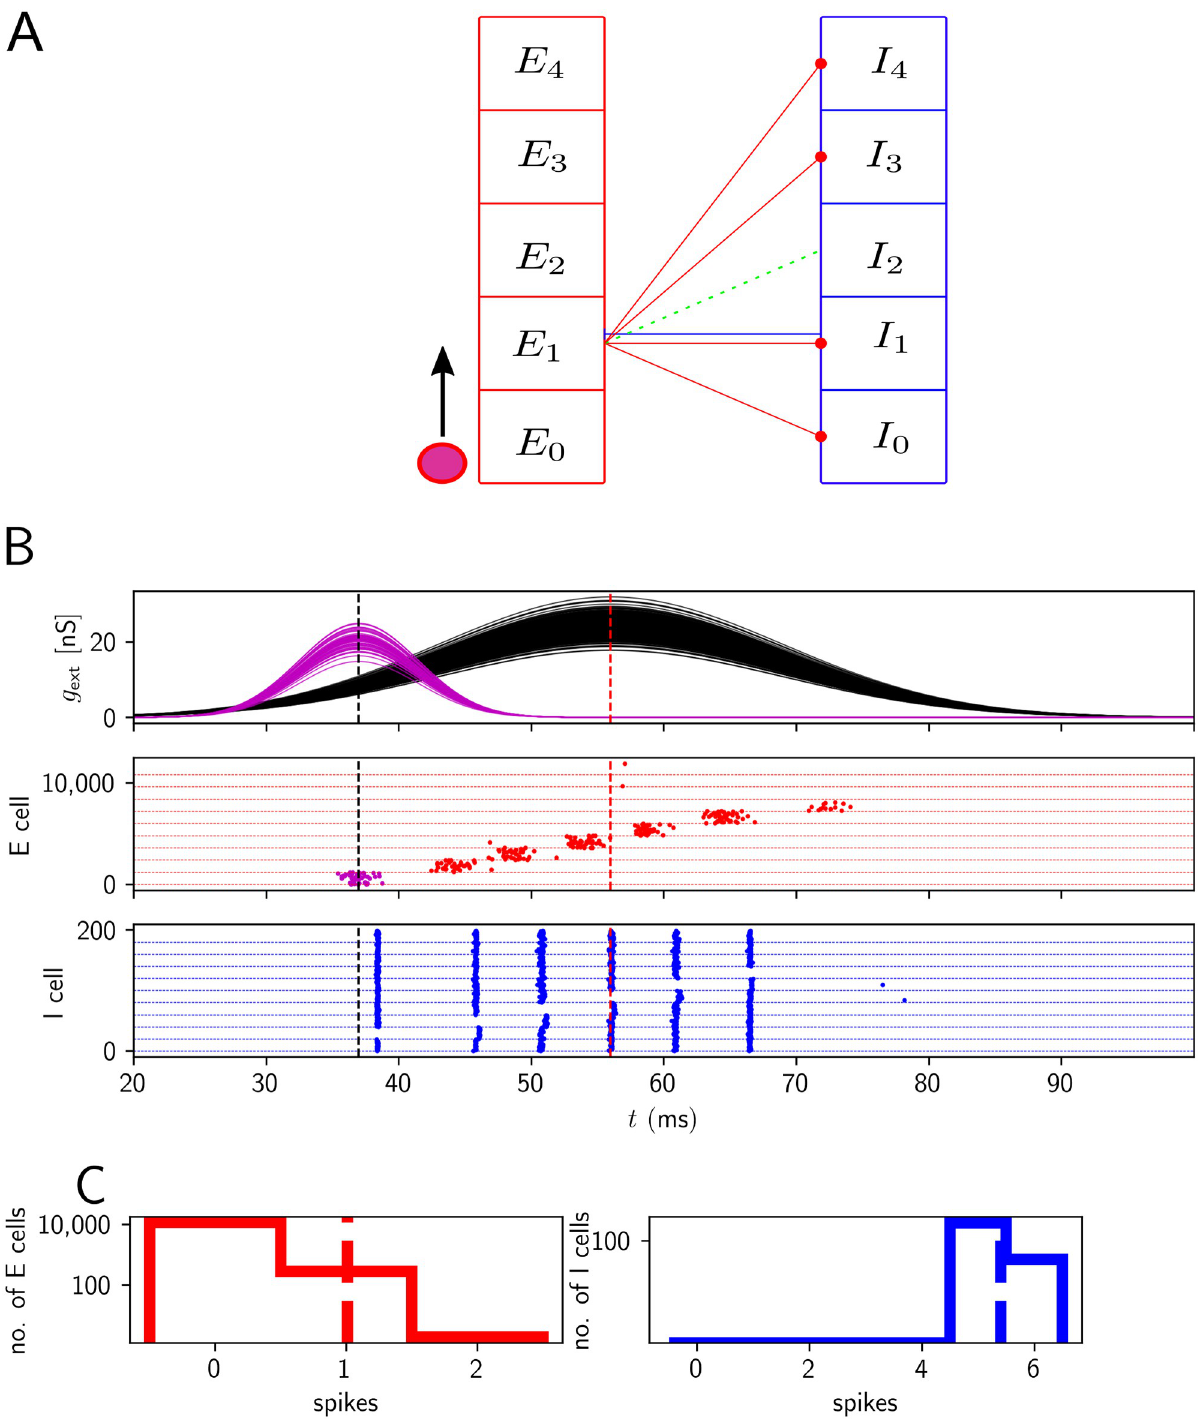
Fig 9. Replay events and ripple oscillations induced by pulse and gap coding of E cells and I cells. The sequence replay is based on disinhibition of a group of E cells and the resulting excitation of all but one group of I cells, which in turn disinhibits another group of E cells. A: Connectivity scheme. Both the E cells and the I cells are grouped into K + 1 groups (here: K = 4 was chosen for simplicity, in the simulations below, K = 9). Group E 1 excites all groups of I cells except I 2 (green dashed line). Similarly, group E single group E k ; that is, group I 0 inhibits group E 0 , group I 1 inhibits group E 1 , and so on. All connections relevant for the sequence generation are shown for group E 1 and I 1 . A replay event is triggered by the initial stimulation of group E 0 . The subsequent activation by CA3 lets E neurons spike